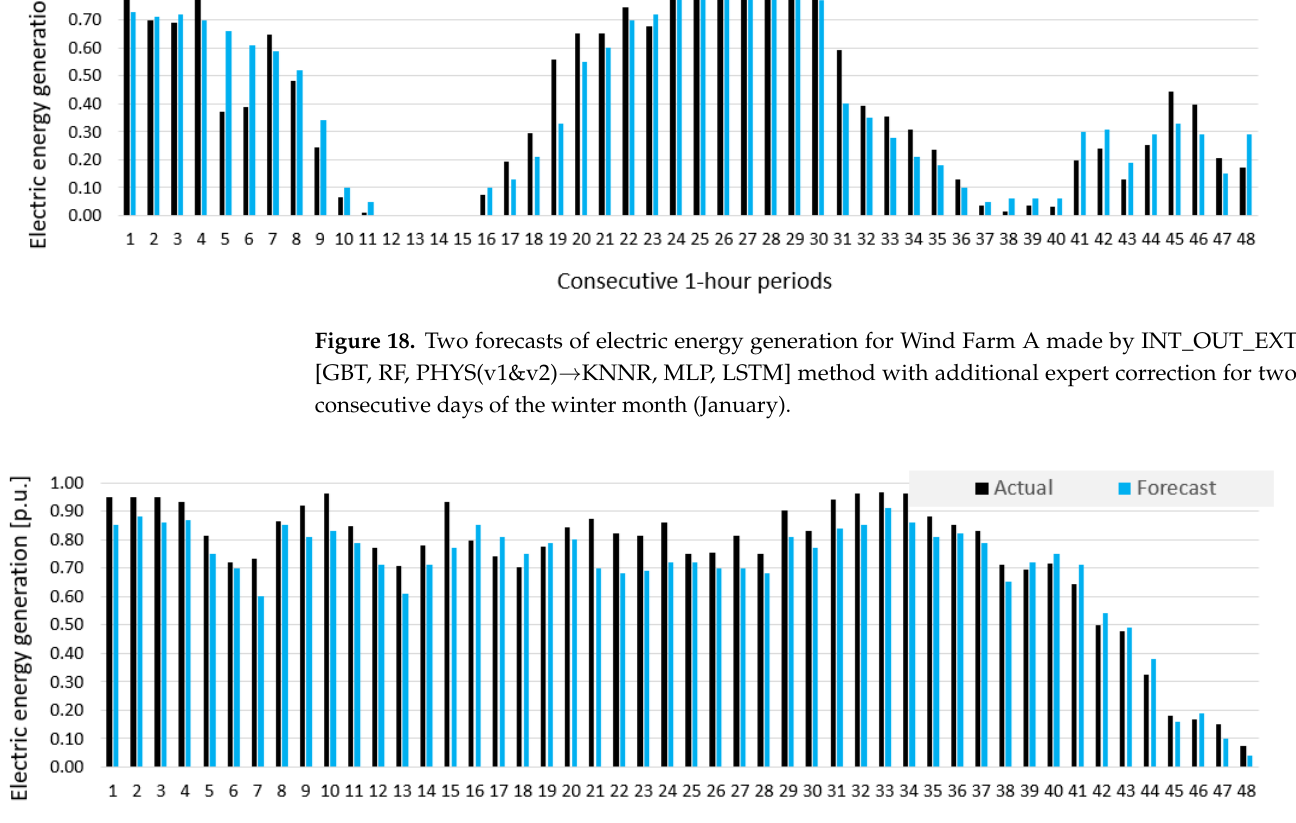
Figure 19. Two forecasts of electric energy generation for Wind Farm A made by INT_OUT_EXT [GBT, RF, PHYS(v1&v2) → KNNR, MLP, LSTM] method with additional expert correction for two consecutive days of the spring month (April).